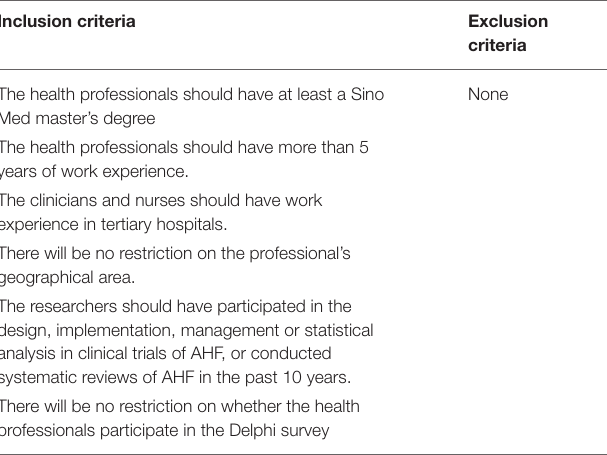
TABLE 6 | The inclusion and exclusion criteria for health professionals in consensus meeting. Inclusion criteria Exclusion